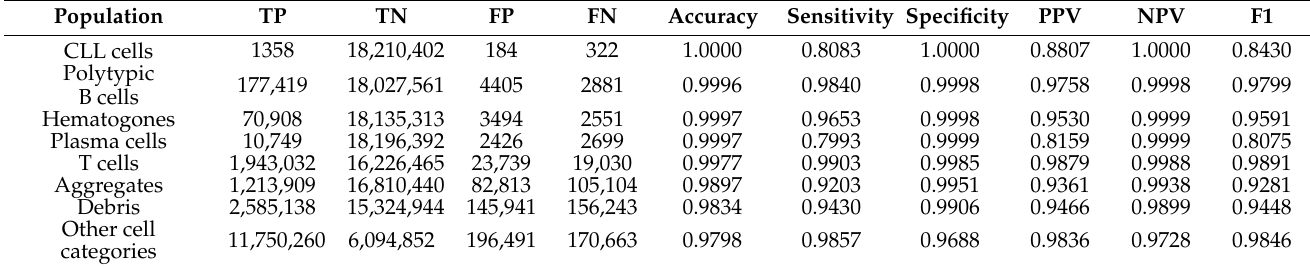
Table 2. Performance metrics of the L-DNN for cell populations of interest using the test cohort (n = 18,212,266 events from 138 unique cases). Accuracy, sensitivity, specificity, PPV, and NPV are presented as dimensionless